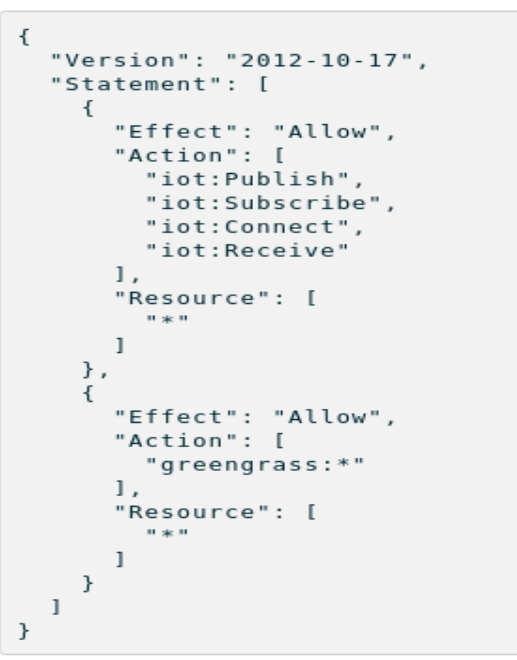
Figure 8. Modified device policy to include the edge layer in the proposed model.